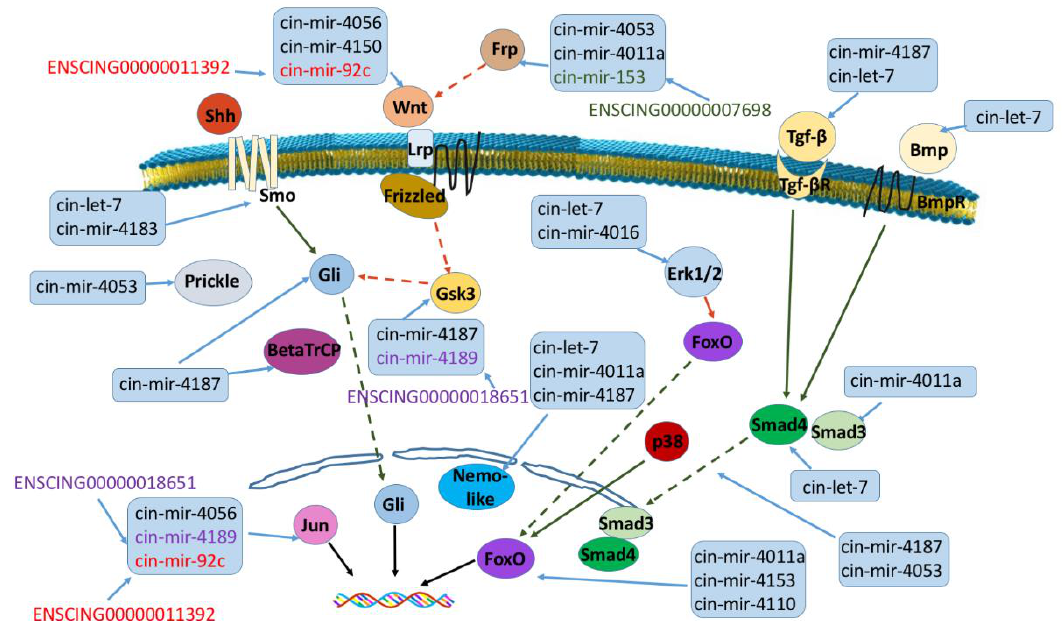
Figure 8. ceRNA network reconstruction of Wn t, Tgf-β , FoxO and Hh pathways. Schematic representation of RNA-interacting molecules evidenced by miRNATIP algorithm is shown. Red arrow is inhibition, green arrow is activation, dashed line in indirect link. The same color in a ceRNA interacting couple (miRNA and pseudogene) indicate a direct interaction between the two RNA molecules.